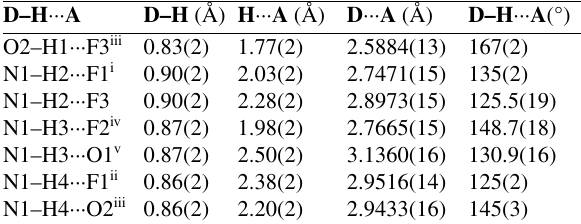
Figure 4. The Raman spectrum of (NH Raman band frequencies and relative intensities (given in parenthe- ses) denoted. The regions (1750–2900 and 3500–3900 cm –1 ) where no signals were observed are